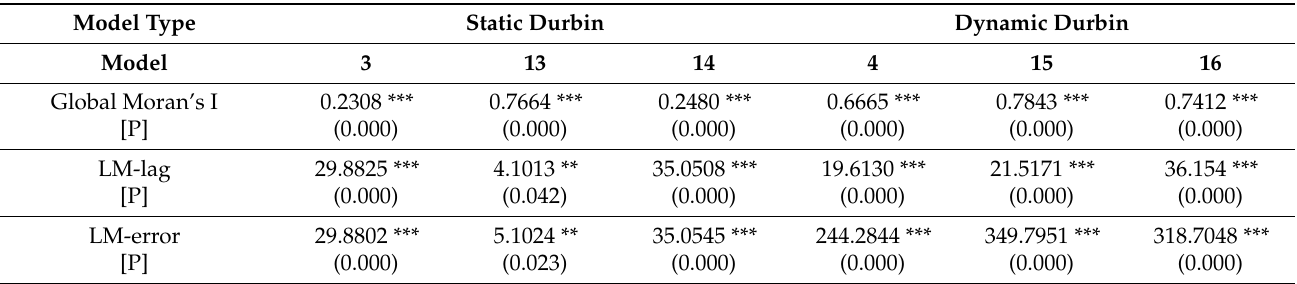
Table 3. Spatial Correlation